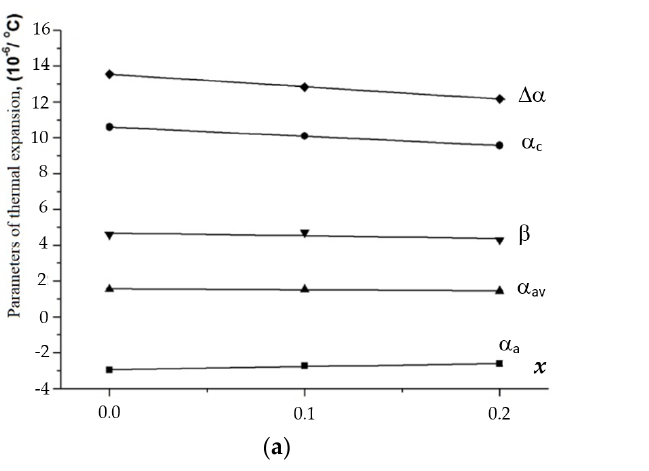
Figure 13. Dependencies of the thermal expansion parameters (α a , α c , α av , β, and Δα) on the compositions ( x ) of phosphates Ca 0.5(1-x) Zr 2 (PO 4 ) 3-x (XO 4 ) x , X = Mo ( a ), W ( b ).